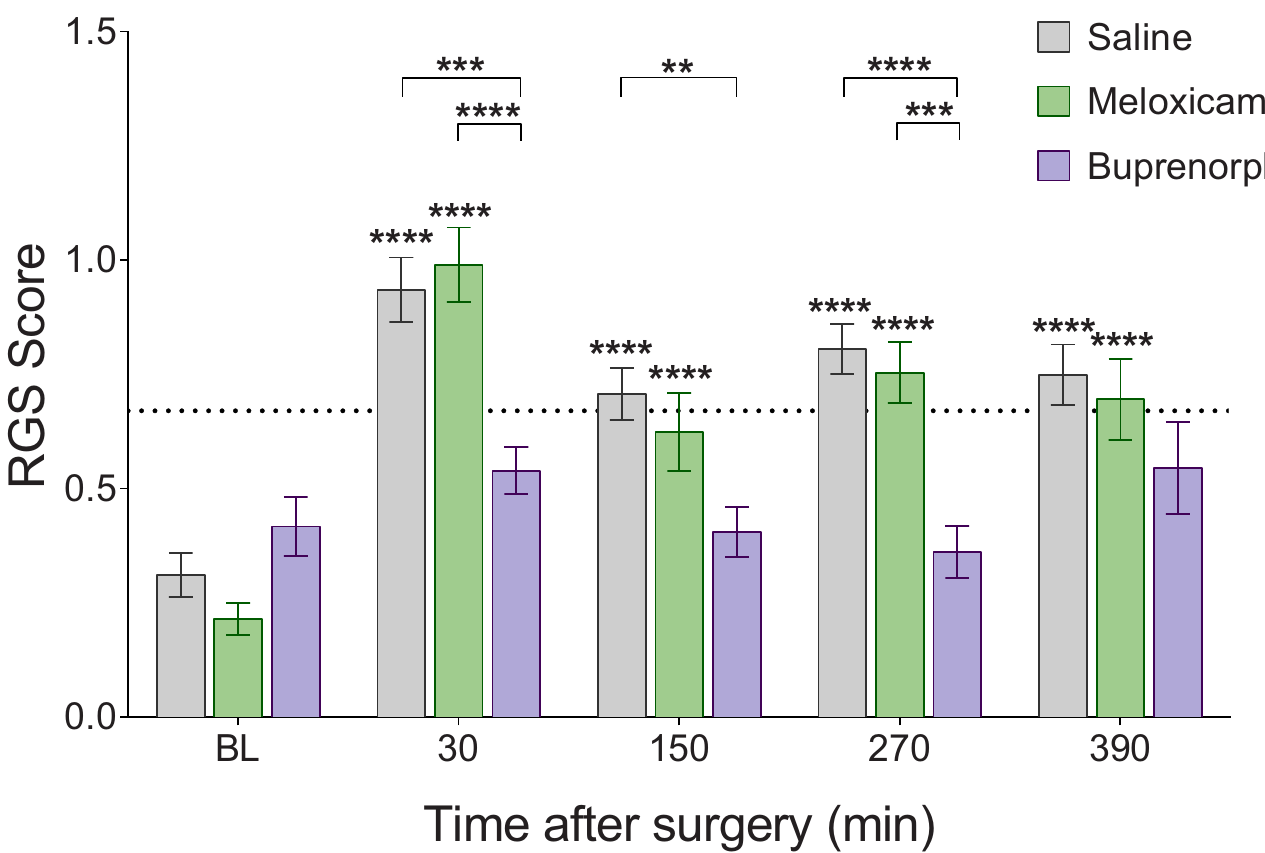
Fig 1. Rat Grimace Scale scores are reduced by the administration of buprenorphine after laparotomy. Saline (n = 21), meloxicam (n = 16) and buprenorphine (n = 15) groups at all time points. Data presented as mean ± SEM. BL = baseline. Asterisks above bars indicate within group differences from baseline. Asterisks with brackets indicate differences between groups. Horizontal broken line at y = 0.67 indicates analgesic intervention threshold [11].